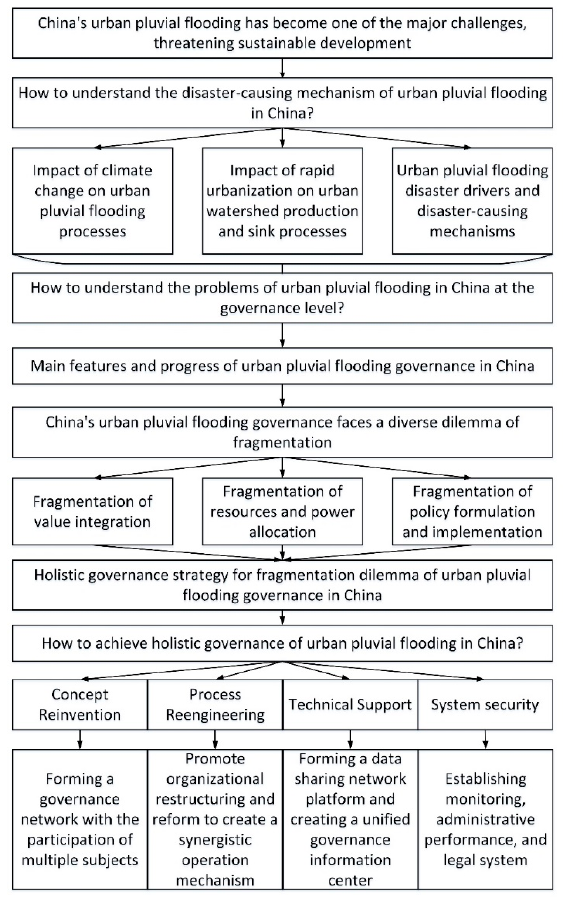
Figure 1. Logical framework of disaster-causing mechanism, main features and progress, governance dilemma and holistic governance of urban pluvial flooding in